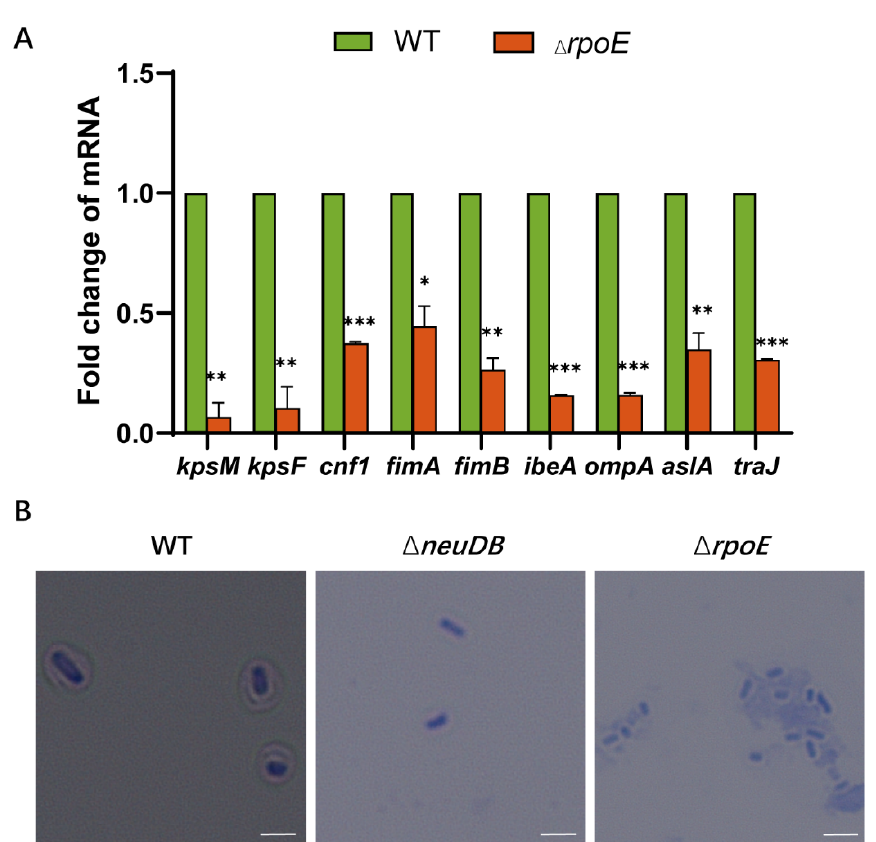
Figure 3. RpoE is a positive virulence regulator of E. coli K1. ( A ) Fold changes in genes transcription in the rpoE mutant strain relative to their expression in the WT strain are shown. ( B ) Capsule morphology Scale bar, 3 μ m. Capsule staining of WT, Δ neuDB , and Δ rpoE strains * p < 0.05; ** p < 0.01; *** p < 0.001.